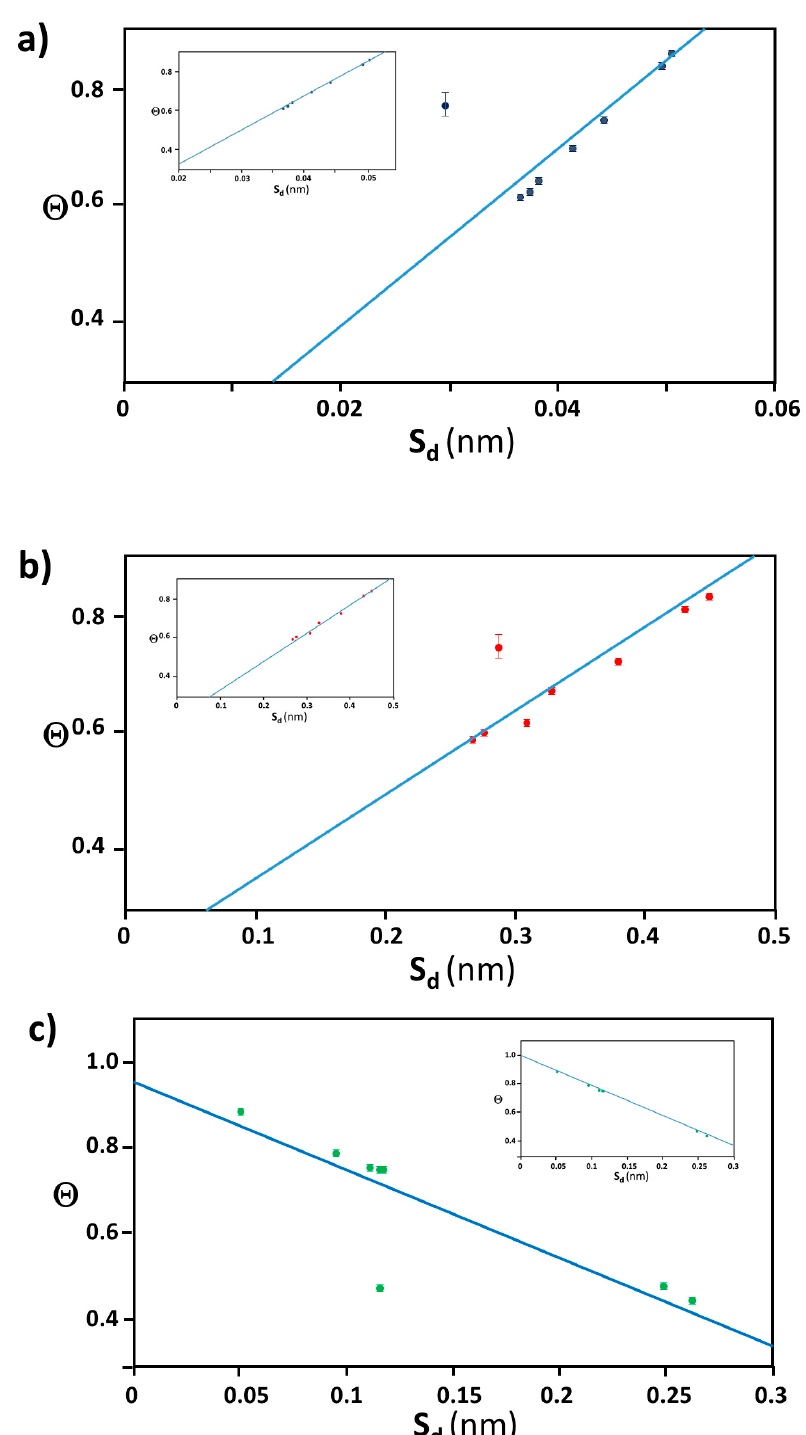
Figure 7. The best optimized plot of Θ vs. S d for ( a ) A β 1–40 in blue, ( b ) α -syn in red, and ( c ) β 2m in green, where fitting values for the linear relationship Θ = Φ S d + ε . In each plot, there was always one deviating data point from the linear trend ( d = 80 nm for A β 1–40 and α -syn, d = 60 nm for β 2m), and the insets show the plot when each outlier point was removed. Supporting information of this figure is available at www.mdpi/xxx/s1.